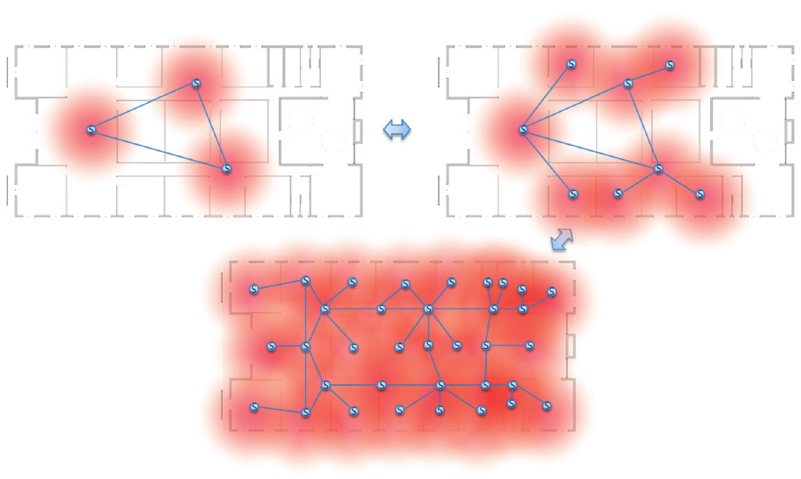
Figure 2. Dynamic space expansion and reduction.